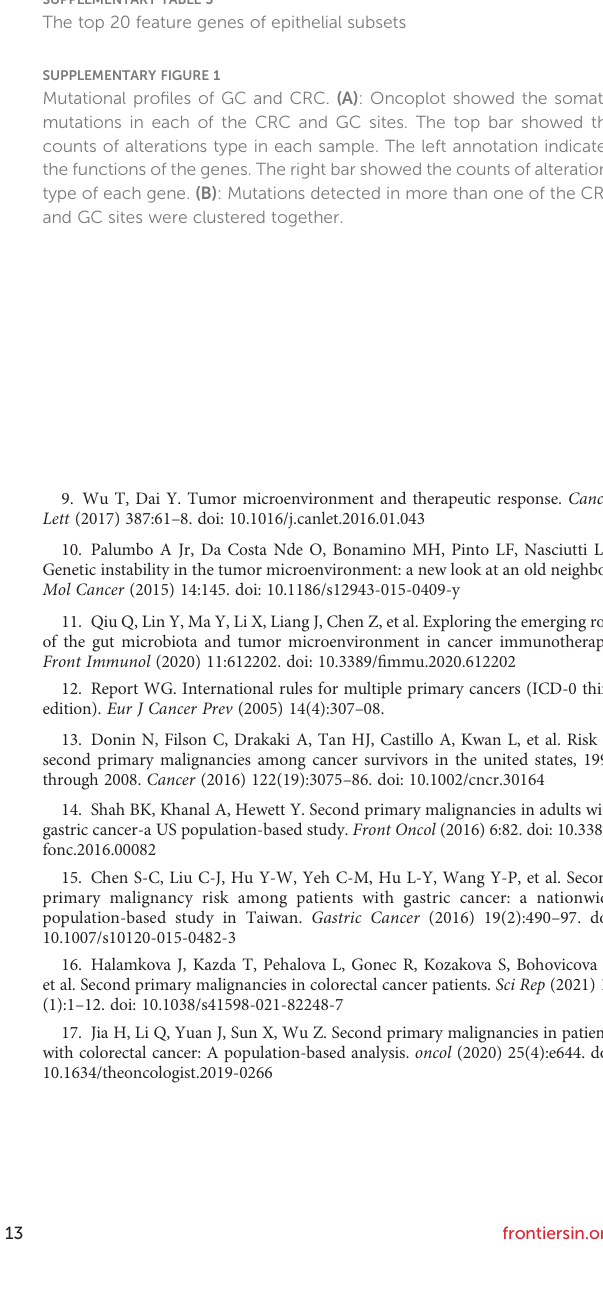
SUPPLEMENTARY TABLE 3 The top 20 feature genes of epithelial subsets